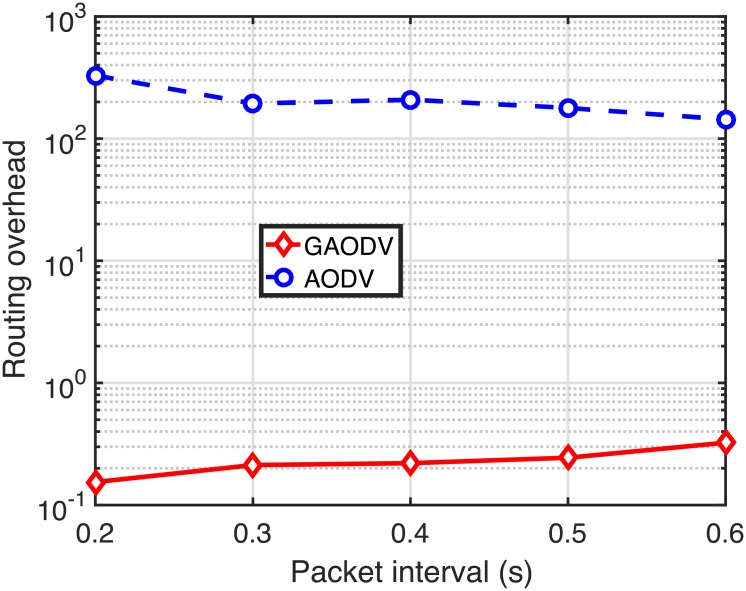
Routing overhead for the change of the packet interval when NCBR = 10 and vmax = 5 m/s.